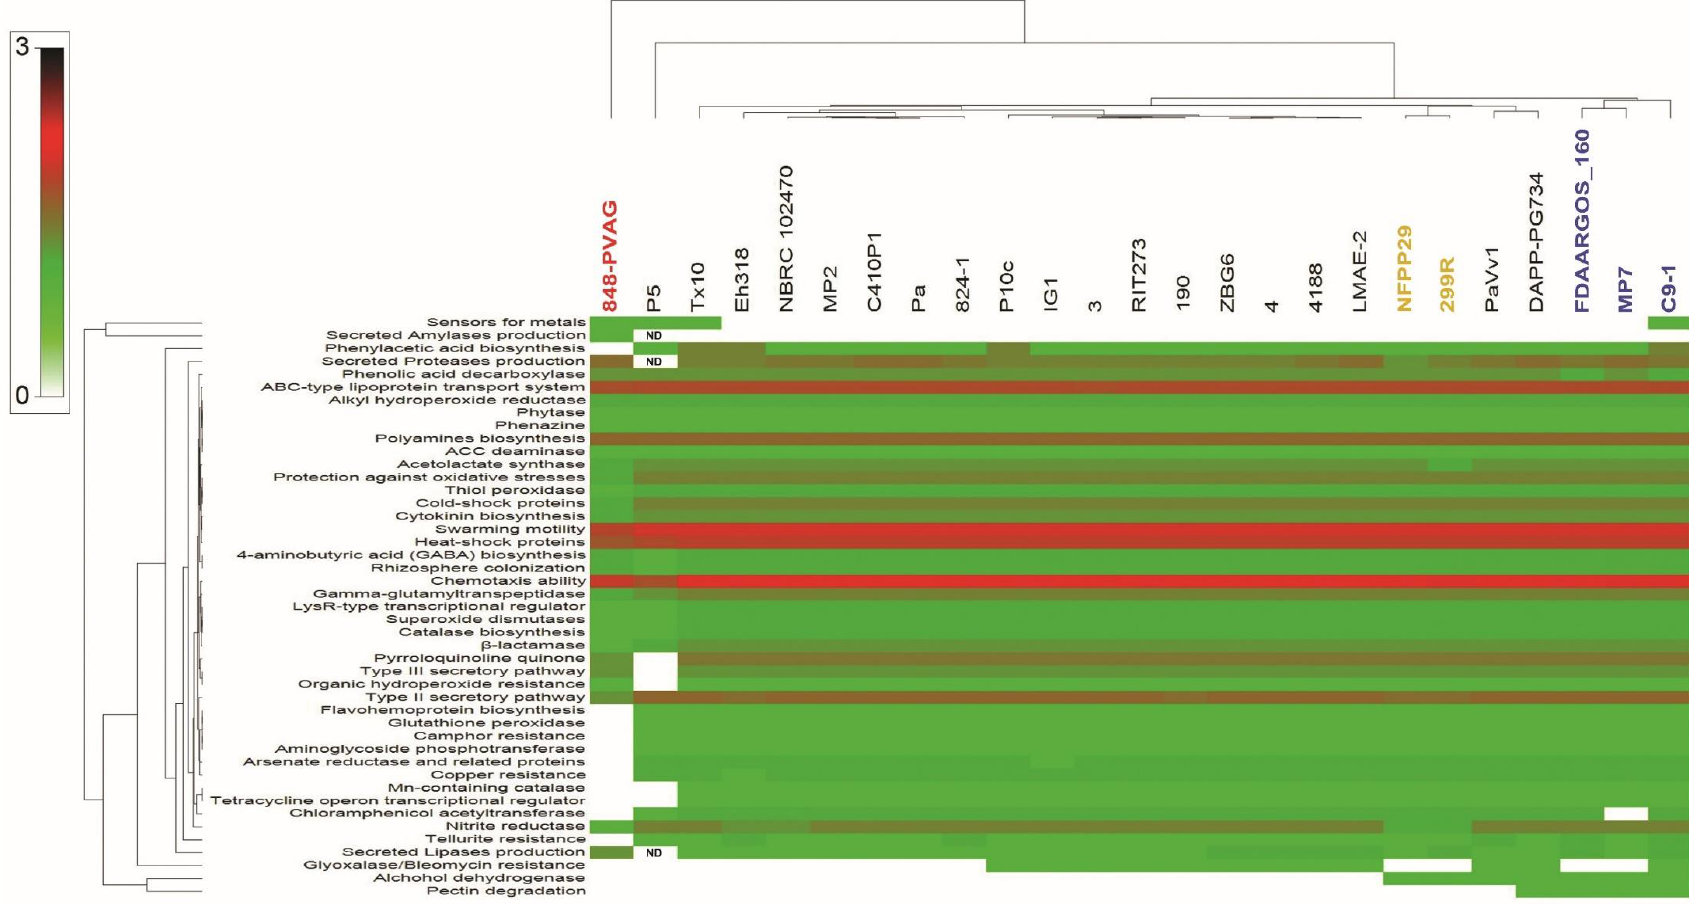
Figure 10. Genome mining of plant-beneficial function genes in Pantoea agglomerans and P. vagans strains illustrated by a heat map. Same colors are used for labeling strains of the same species. 3